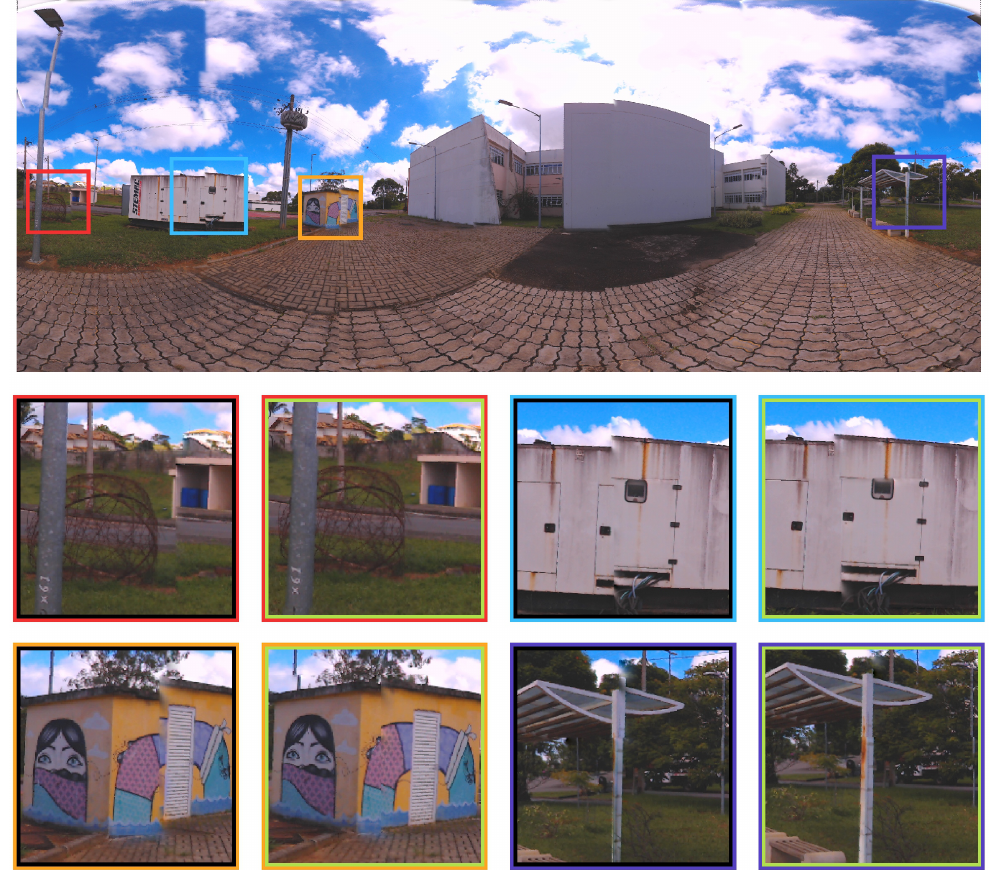
Figure 18. Case study II - Zoomed figures of four different spots represented by the red, cyan, yellow and dark blue squares show the nuance of each optimization